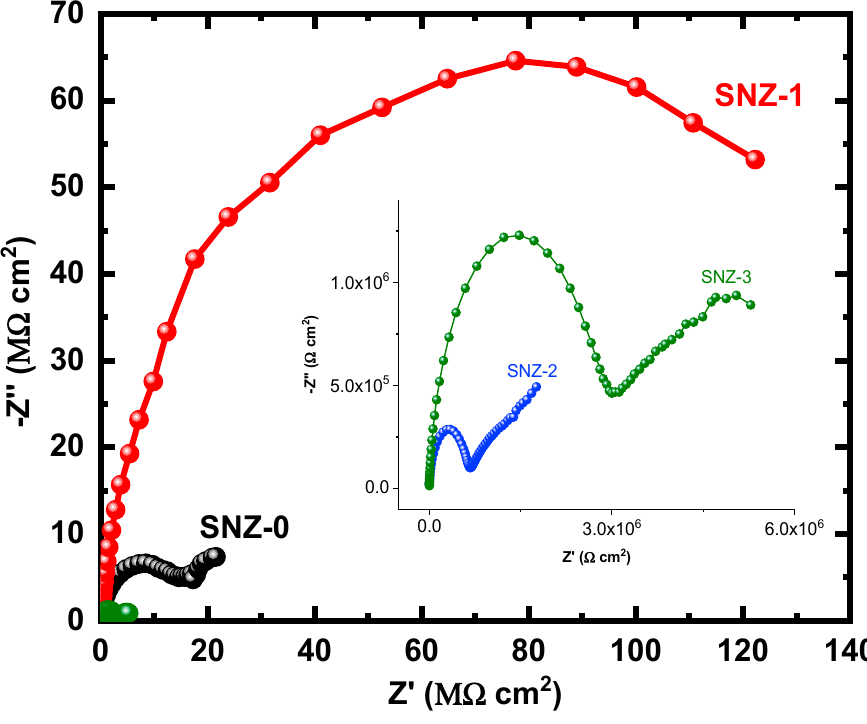
Figure 8. Nyquist plots of the coatings after 20 days’ immersion in a 3.5% NaCl solution.